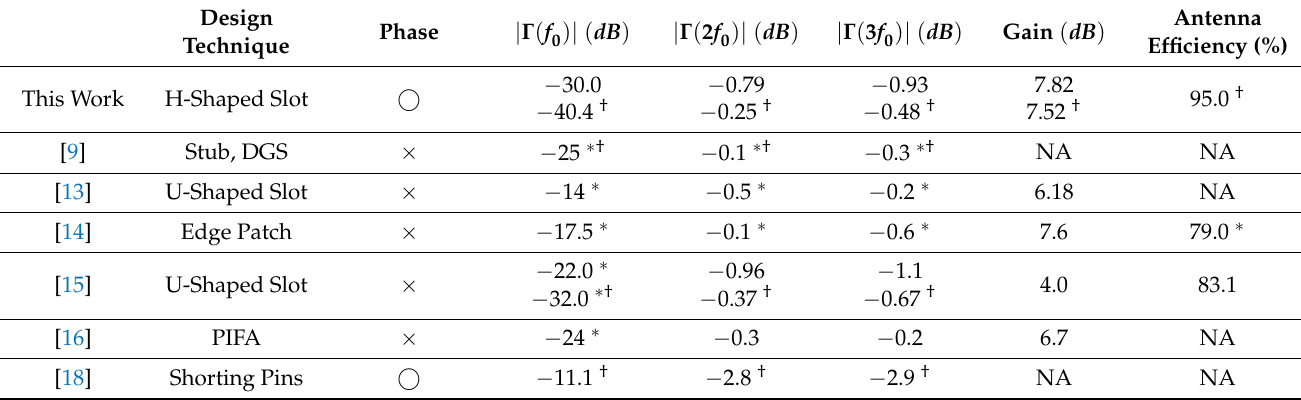
* Read value from figure. †: simulation value. (cid:13) : with adjustment function. × : without adjustment function. NA: not